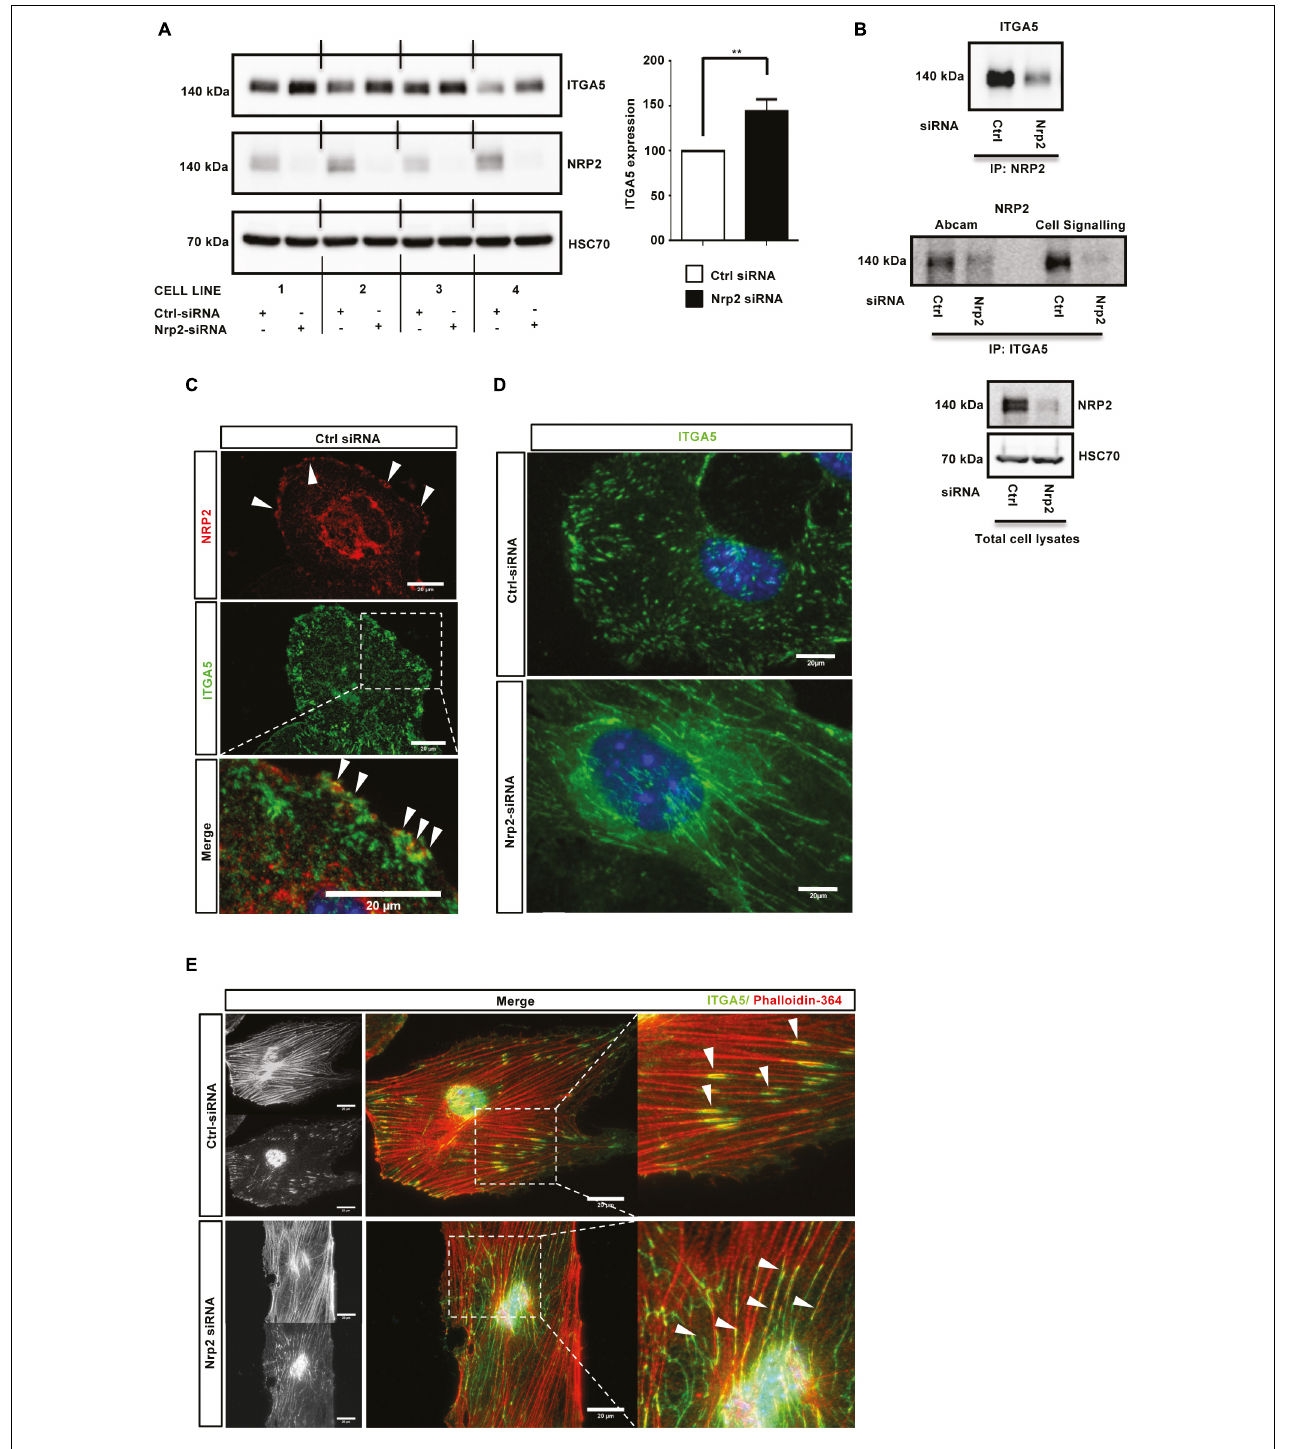
FIGURE 3 | NRP2 regulates ITGA5 expression in ECs. (A) : siRNA-transfected ECs from four different clones were seeded onto FN and incubated for 48 h. EC extracts were immunoblotted using antibodies to ITGA5, NRP2, and HSC70. Left panel shows Western blot image, right panel shows densitometric analysis of ITGA5 band intensities normalized against HSC70 and obtained using ImageJ TM . ** P < 0.01. (B) : siRNA-transfected ECs were seeded onto FN and incubated for 48 h. Left panel: EC extracts were immunoprecipitated by incubation with protein-G Dynabeads R (cid:13) coupled to a NRP2 antibody. Middle panel: EC extracts were immunoprecipitated by incubation with protein-G Dynabeads R (cid:13) coupled to two different ITGA5 antibodies (as indicated). Immunoprecipitated complexes were subjected to Western blot analysis using antibodies against ITGA5 and NRP2, respectively. Right panel: NRP2 silencing was confirmed by subjecting the total cell